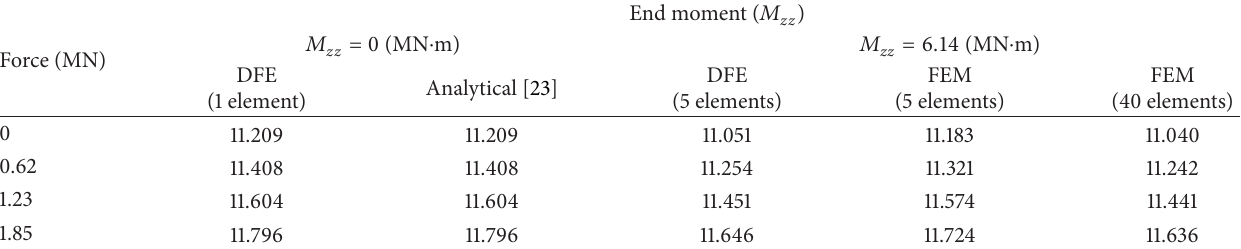
Table 4: DFE fundamental frequencies (Hz) for pinned-clamped (P-C) boundary